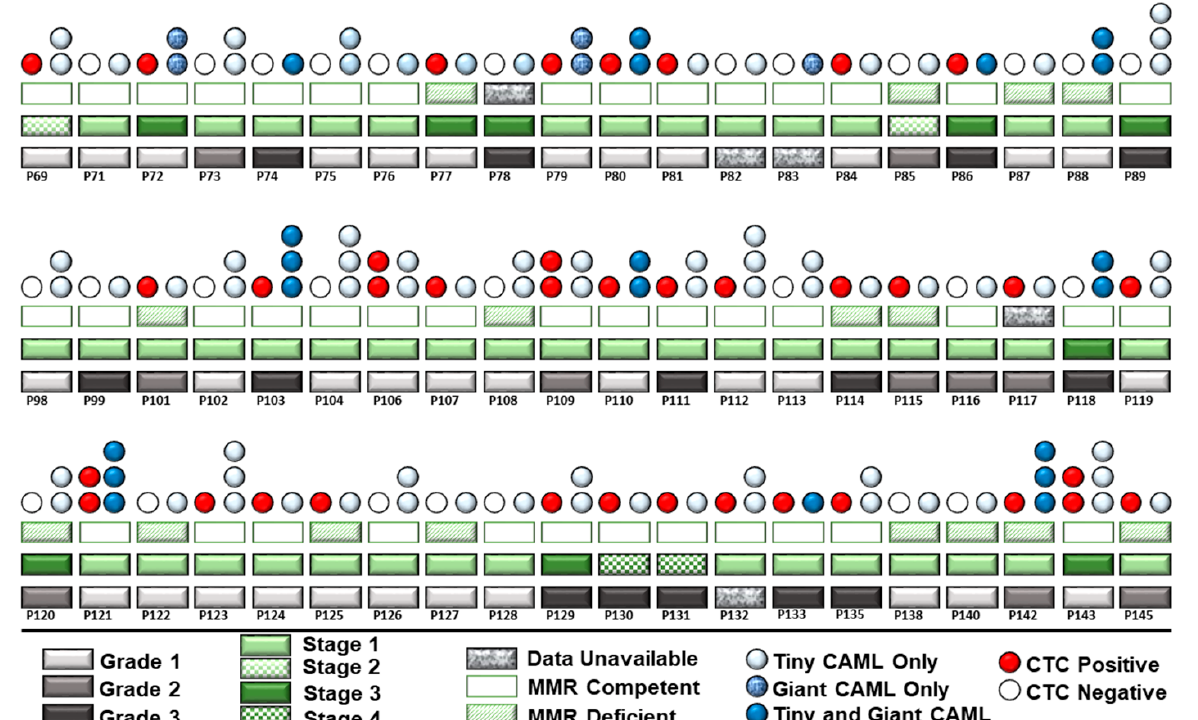
Figure 6. Composite representation of the presence of the size-based types of CAMLs with the histological stages, grades, MMR status, and CTC status in 60 consecutive patients with endometrial tumors: light-grey rectangles for Grade 1, dark-grey rectangles for Grade 2, and black rectangles for Grade 3; light-green rectangles for Stage I; light-green and white checkerboard rectangles for Stage II; dark-green rectangles for stage III; and dark-green and white checkerboard rectangles for Stage IV; green open rectangle for MMR competent, green-white hatched for MMR deficient; and granite rectangles for unavailable data; light-blue circle for tiny CAML, denim blue-circle for giant CAMLs, and dark-blue circles for tiny plus giant CAMLs; red circles represent CTC-positive, and open-circles represent CTC-negative patients. Quantitatively, one blue circle represents a few, two vertical circles represent frequent, and three vertical circles represent abundant CAMLs in the blood. Each patient is represented in a column.